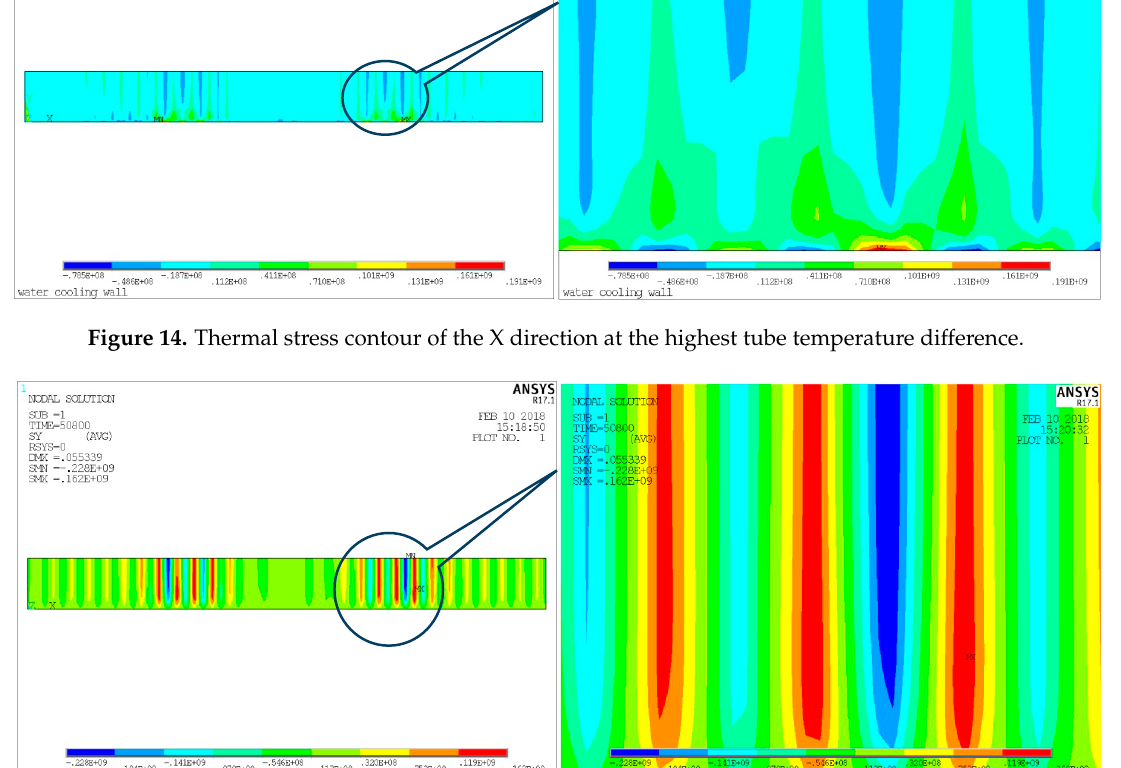
Figure 14. Thermal stress contour of the X direction at the highest tube temperature difference.